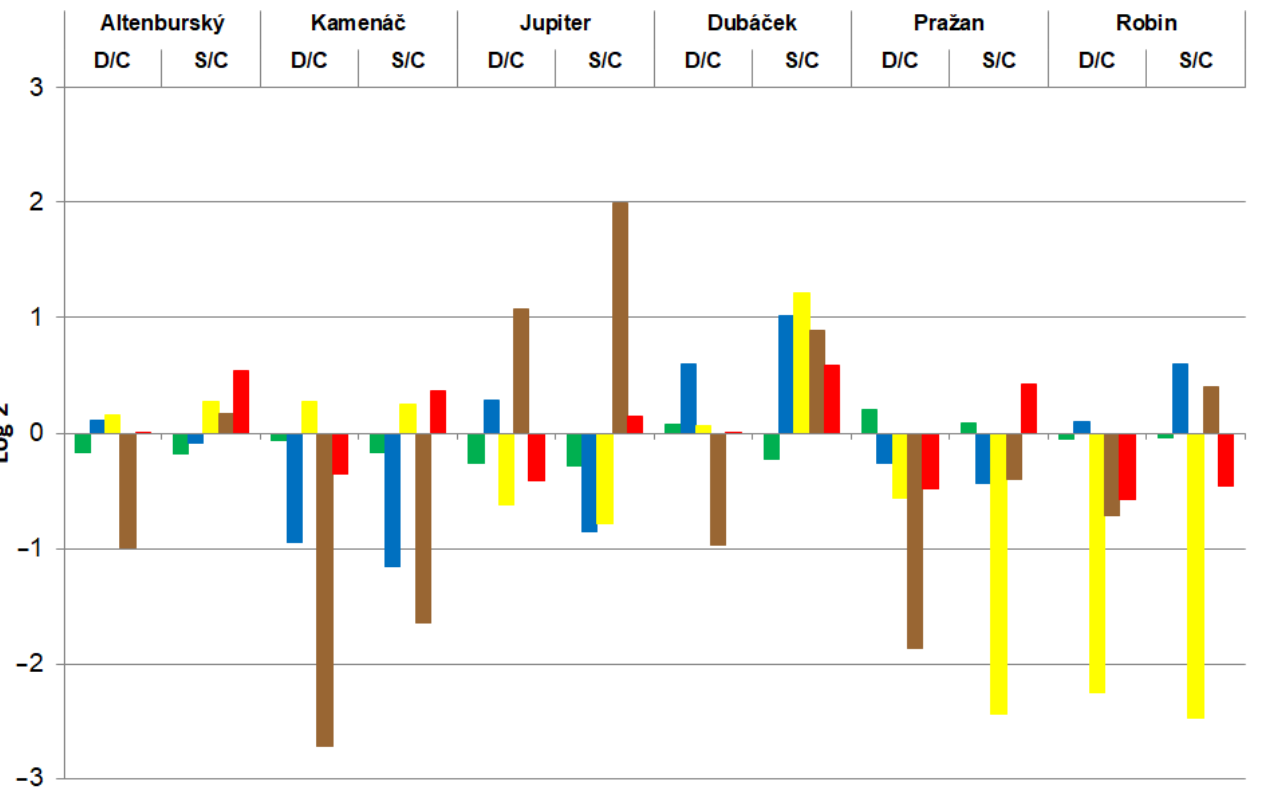
Figure 4. Barplots visualizing the log aratios of the total value of each class of analyzed compounds in drought stress (D) and salt stress (S) to value in the control condition (C).